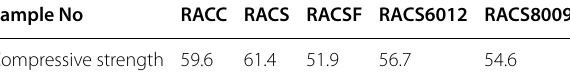
Table 4 Steaming system parameters